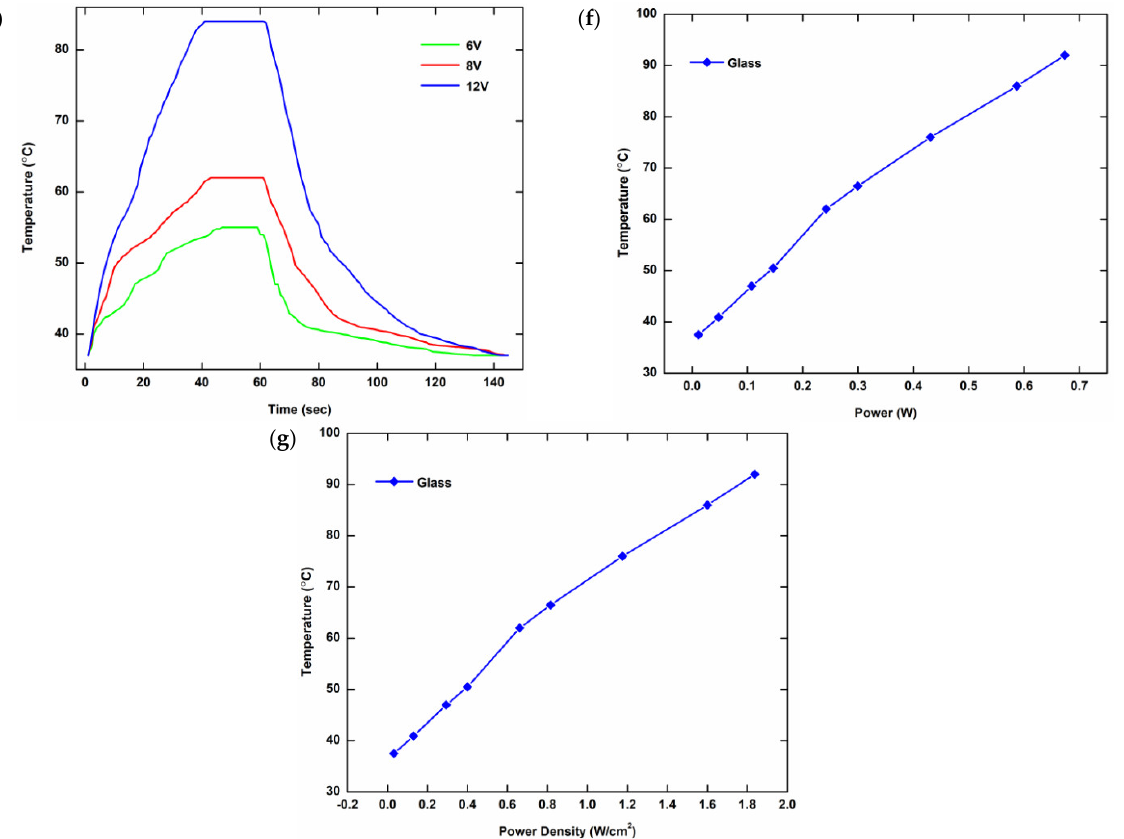
Figure 5. Characterization of printed microheaters. ( a ) Temperature–voltage relationship recorded after 15 s on both glass and PET substrates; ( b ) temperature–voltage relationship measured after 45 s on the glass substrate, printed micro-heater at 12 V, optical image ( c ) and IR image ( d ); ( e ) temperature variation with time at different applied voltages on the glass substrate; ( f ) temperature–power relationship; and ( g ) temperature–power density relationship on glass substrates.